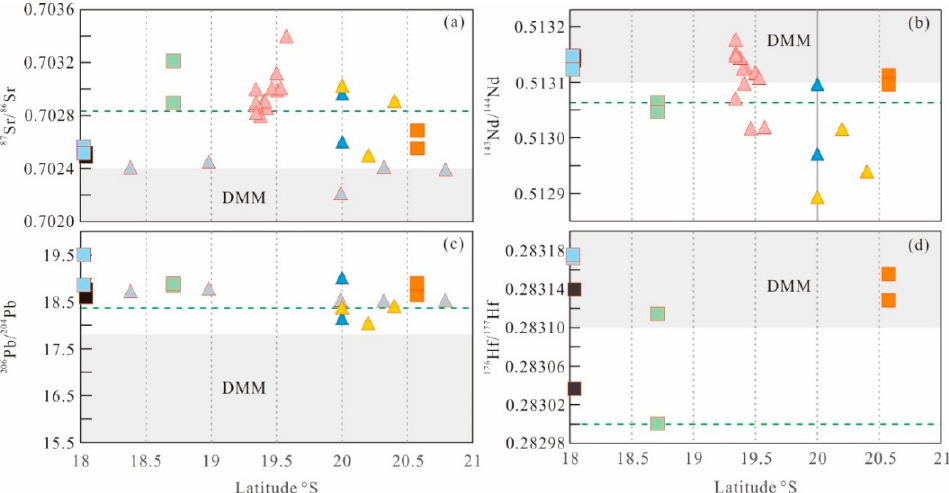
Figure 5. Comparison of the latitudinal variations in 87 Sr/ 86 Sr, 143 Nd/ 144 Nd, 206 Pb/ 204 Pb, and 176 Hf/ 177 Hf in the basalts from the SMAR at 18–21°S. The DMM values are from [42]. The green dotted line represents the average MORB isotopic composition from [55], with 87 Sr/ 86 Sr = 0.702819 ( n = 272), 143 Nd/ 144 Nd = 0.513074 ( n = 272), 206 Pb/ 204 Pb = 18.412 ( n = 245), and 176 Hf/ 177 Hf = 0.283 ( n = 138). Symbols are the same as in Figure 2. In Figure 5, the basalts from the SMAR at 18–21°S have broad ranges of 87 Sr/ 86 Sr ( a ), 143 Nd/ 144 Nd ( b ), and 176 Hf/ 177 Hf ( d ) ratios relative to those of the DMM and the average MORB and yield 206 Pb / 204 Pb ratios mostly higher than those of the DMM and the average MORB ( c